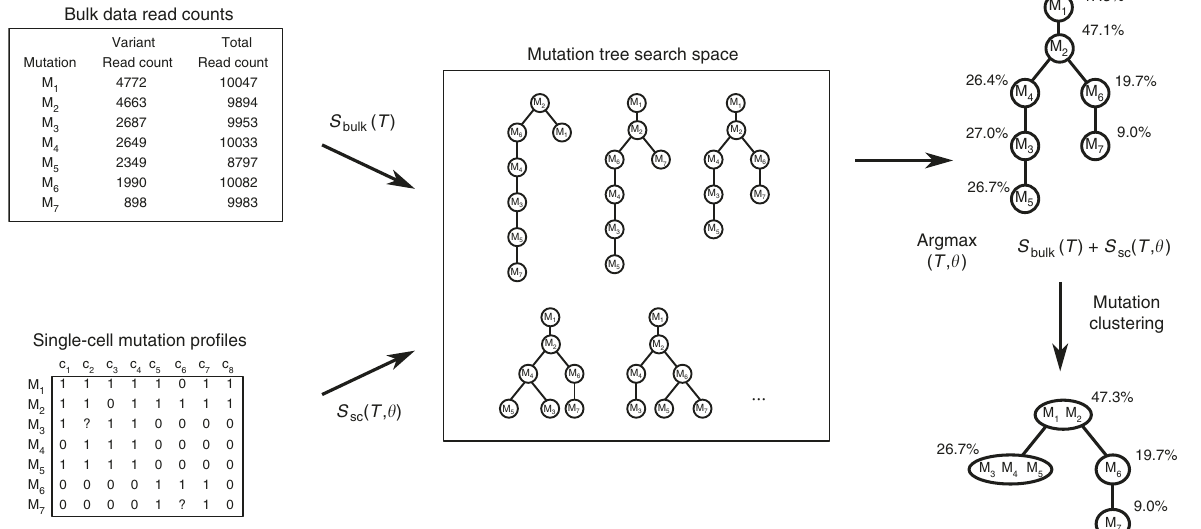
Fig. 2 B-SCITE uses a Markov chain Monte Carlo approach to search the space of candidate mutation histories. Each candidate tree is scored based on its joint fi t to the single-cell and bulk DNA sequencing data. The bulk data consist of a high-coverage variant and total read counts for the mutated loci. The single-cell data consist of the observed mutation pro fi les of the sequenced cells. These single-cell pro fi les are characterised by high noise rates ( θ ) that are learned from the SCS data along with the tree topology T . B-SCITE reports the tree with the highest joint score. This tree is a fully resolved mutation tree. To obtain a clonal tree, the linear tree parts can be clustered based on the variant allele frequencies of the bulk data NATURE COMMUNICATIONS| (2019) 10:2750